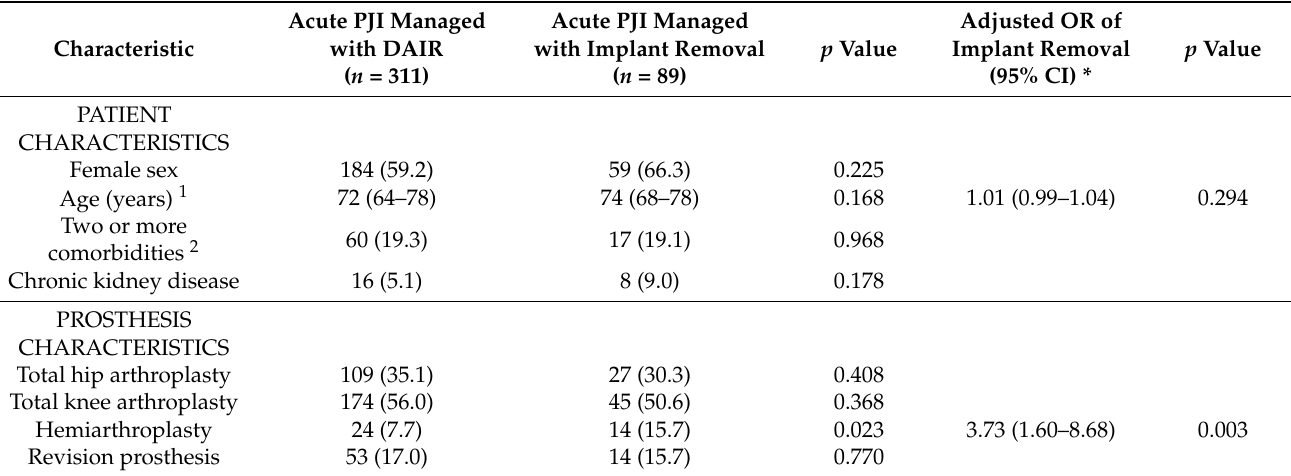
Table 1. Characteristics, adjusted odds ratios of implant removal and outcome of 400 cases of acute prosthetic joint infection (early post-surgical and hematogenous) by Staphylococcus aureus , according to their initial surgical management.